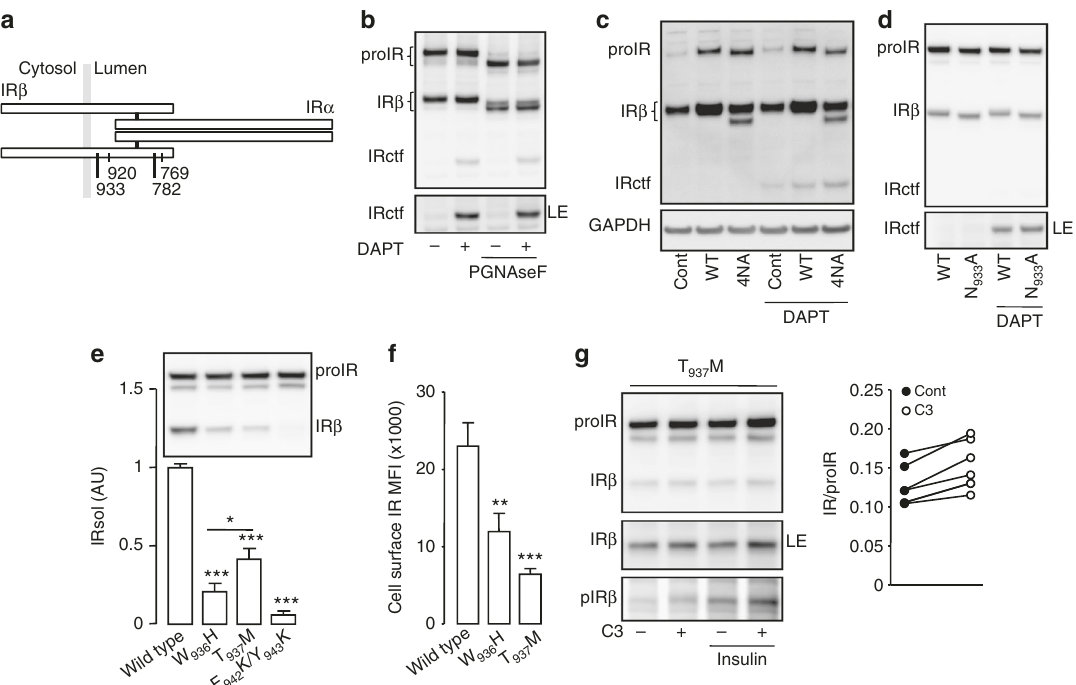
Fig. 4 Identi fi cation of the IR cleavage region. a Schematic representation of IR positioning the N -glycosylation sites in the β -subunit. b HEK 293 cells were transfected and treated as described in Fig. 1b. Where indicated cell lysates were in vitro deglycosylated by PGNaseF. c CHO cells were transfected with an empty plasmid (Cont), an IR expression vector (WT) or with a plasmid expressing a mutated form of IR that cannot be glycosylated on its β -subunit (4NA), then treated with DAPT. d HEK 293 cells were transfected with an IR expression vector (WT) or with a plasmid expressing a mutated form of IR that cannot be glycosylated on the position 933 (N 933 A), then treated with DAPT. HEK 293 cells expressing BACE1 were transfected with wild-type IR or the indicated mutated forms of IR, then the IRsol accumulated in the conditioned media was measured by ELISA, and cellular expression of IR was analyzed by immunoblot ( e ), cell surface expression of IR was measured by fl ow cytometry ( f ). g Cells were treated as in Fig. 3c then IR and phospho IR (pIR β ) were detected by immunoblot. LE indicates a long exposure of the immunoblot. The graph shows the ratios IR/proIR obtained from the quanti fi cation of six independent experiments. Data are means ± s.d. Statistical analyses were made using ANOVA, followed by Bonferonni ’ s test ( e , f ) or unpaired t -test ( g ). * p < 0.05; ** p < 0.01; *** p <